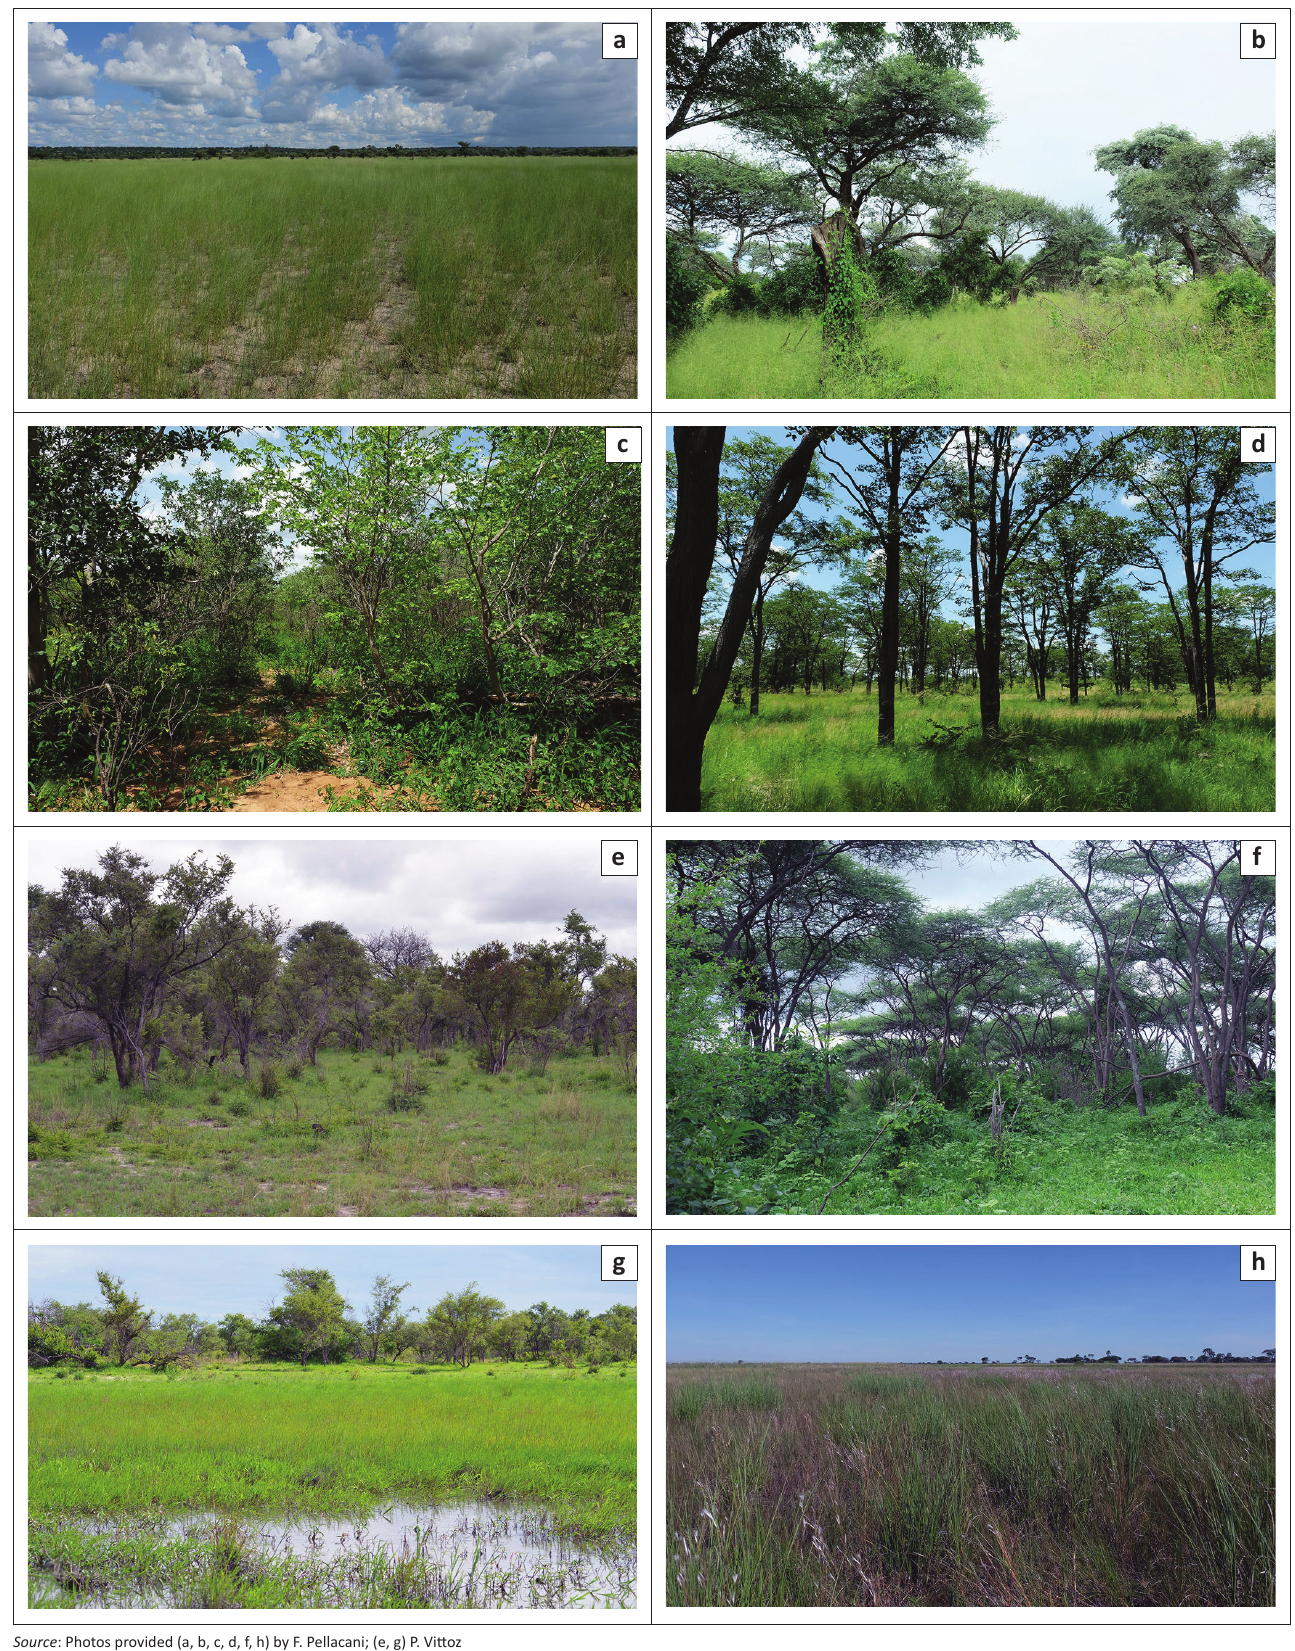
FIGURE 2: Overview of plant communities in the Chobe Enclave. (a) Aristida junciformis ‒ Aristida meridionalis grassland, dominated by A. junciformis and A. meridionalis (plot 71); (b) Ipomoea chloroneura ‒ Oxygonum alatum woodland, with Terminalia sericea, Vachellia erioloba and Panicum maximum (plot 48); (c) Baikiaea plurijuga ‒ Baphia massaiensis forest (plot 8); (d) Colophospermum mopane ‒ Jasminum stenolobum woodland, dominated by C. mopane and Aristida adscensionis (plot 36); (e) Eragrostis superba ‒ Combretum hereroense woodland, dominated by C. hereroense and Digitaria eriantha (plot 3); (f) Croton megalobotrys ‒ Setaria verticillata forest, dominated by Vachellia tortilis (plot 16); (g) Geigeria schinzii ‒ Setaria sphacelata grassland, after a heavy rain; (h) Wet floodplain, dominated by Andropogon eucomus (plot